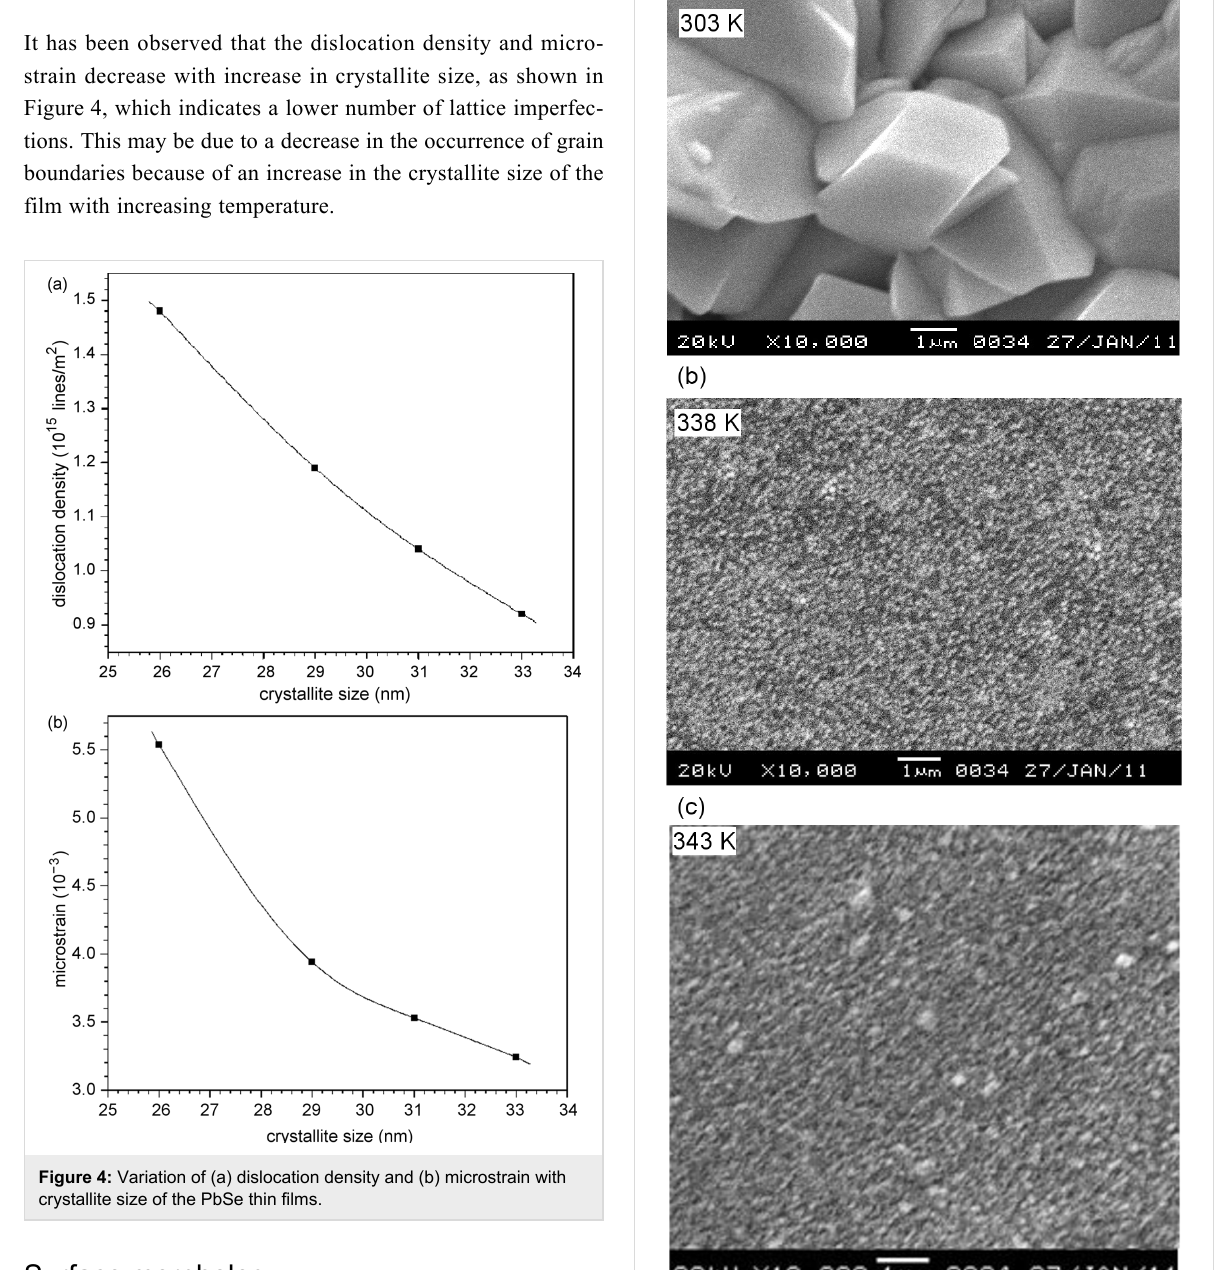
Surface morphology